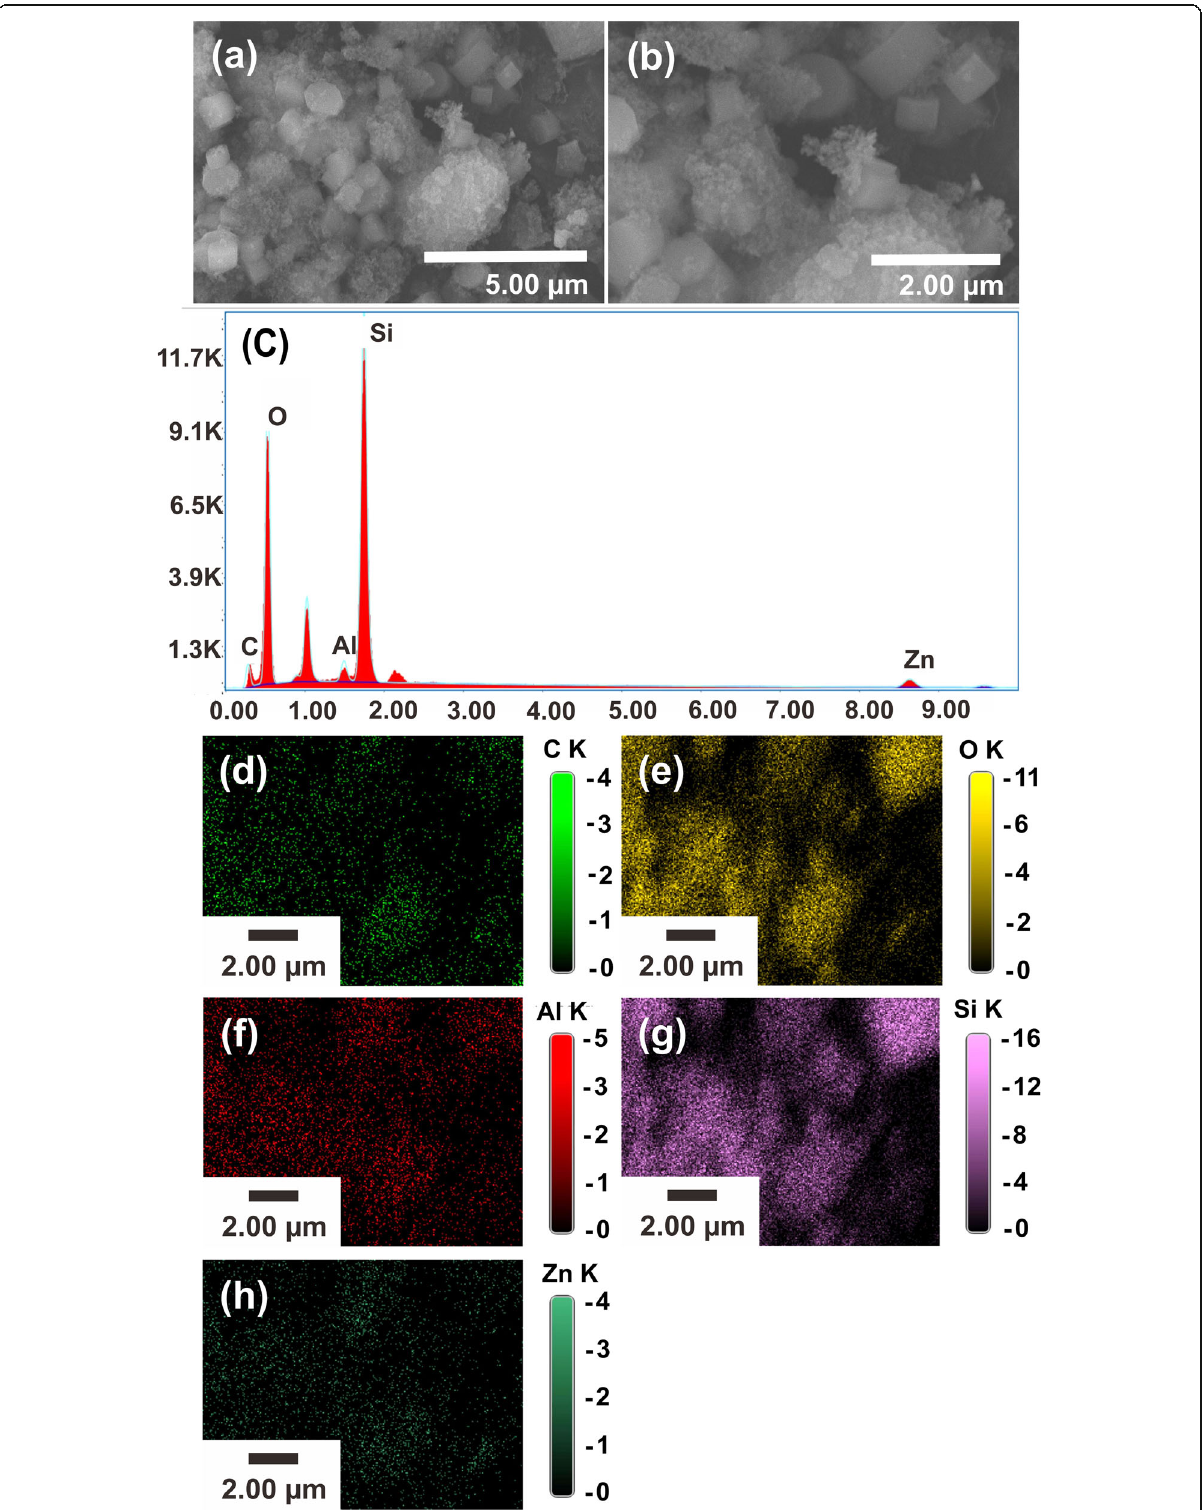
Fig. 5 SEM ( a-b ), EDX (c) and mapping ( d-h ) images of